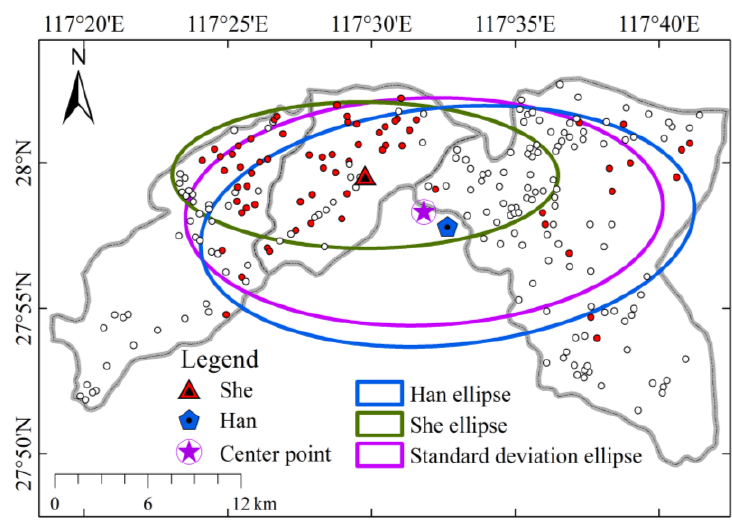
Figure 6. Standard deviational ellipse map of human settlements.